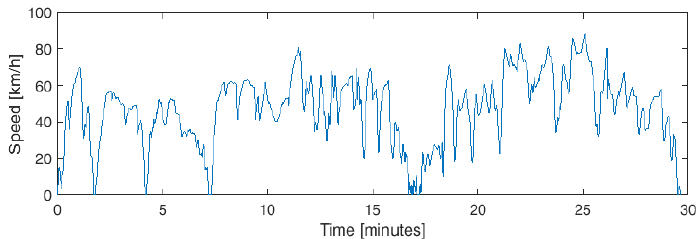
Figure 16. Speed profile, mountain mission 1.